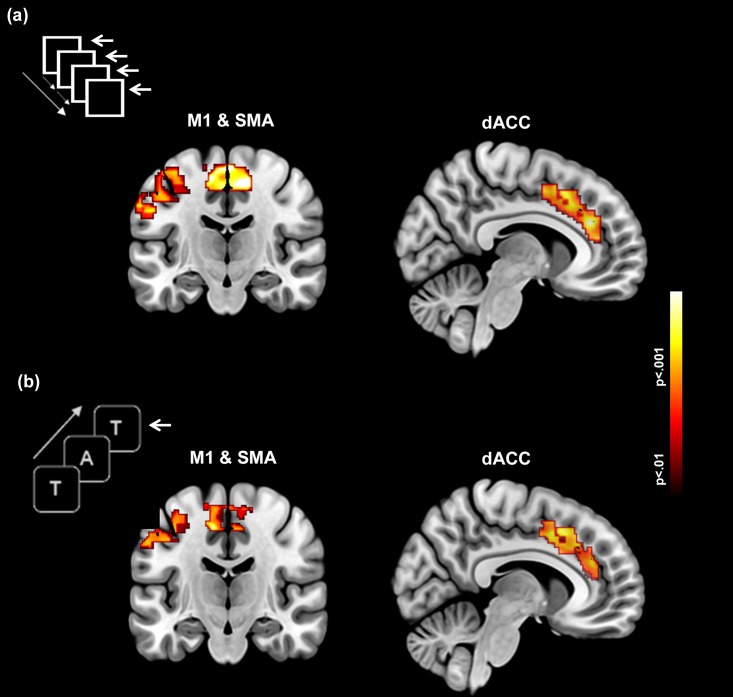
Activation maps are depicted in dACC, SMA and M1 for each of the (a) Motor and (b) Memory paradigms.Each task is schematically depicted in the accompanying graphic. In (a) subjects made a motor response when the visual probe flashed (arrow denotes the finger response). In (b), the motor control demands were secondary to the memory component. Subjects made a motor response when the current memoranda matched the one presented 2 items previously in the sequence (2-Back). As seen across panels, both tasks resulted in robust activation in each of the three regions of interest.